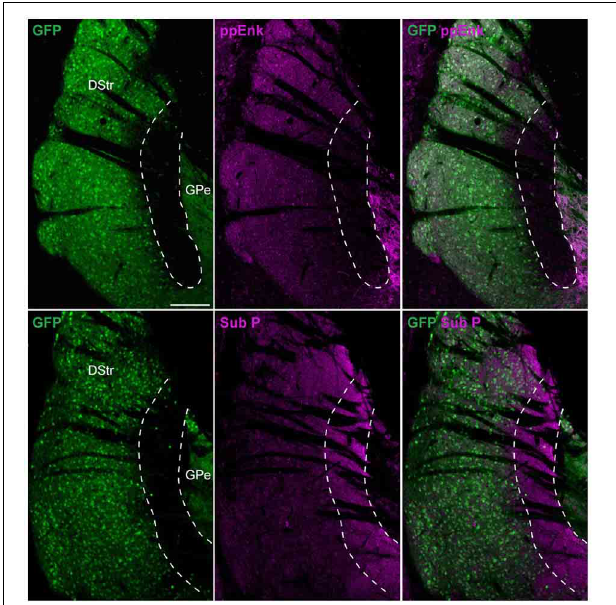
FIGURE 4 | Preproenkephalin and substance P immunoreactivities in the D2R/A2aR-expressing MSNs-poor zone of the caudal striatum. Striatal sections at the caudal level from Drd2-EGFP mice ( n = 5) labeled with antibodies for preproenkephalin (ppEnk, magenta) or substance P (Sub P, magenta) and GFP (green). Note the very low level and the enrichment of preproenkephalin-and substance P-labeling, respectively in the area lacking D2R/A2aR-expressing MSNs. DStr, dorsal striatum; GPe, external globus pallidus, GFP, green fluorescent protein.